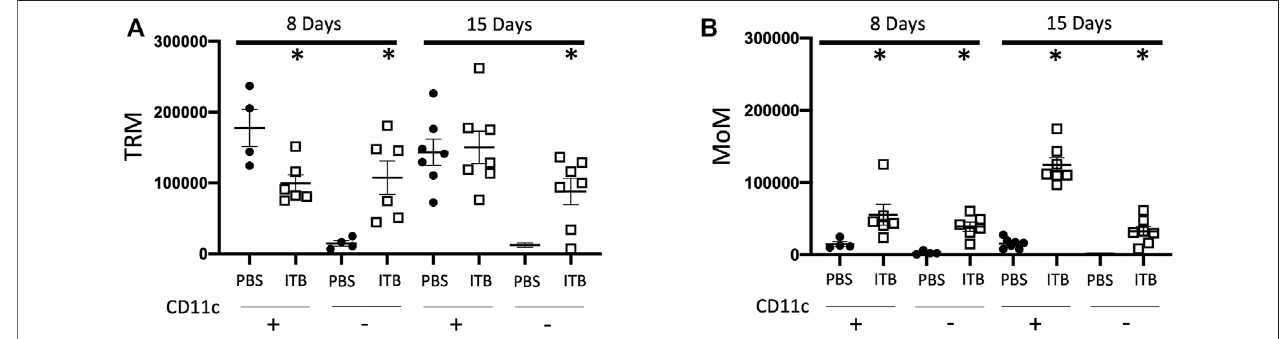
FIGURE 3 | Tissue resident macrophages (TRM) and monocyte originated macrophages (MoM) are dynamic populations following instillation. (A-B) Gated on single live cells, TRMs are GFP- F4/80+ (A) and MoMs are GFP+ F4/80+ (B) . CD11c expression further identi fi es macrophage phenotype. ( n = 4 – 7 per group) * p < 0.05 compared to